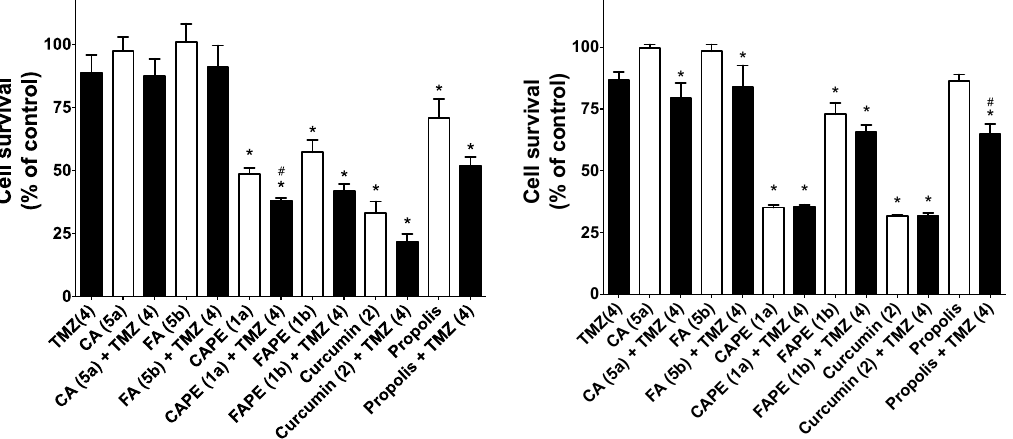
Figure 6. Cell viability of Hs683 ( left panel ) and LN319 ( right panel ) cells following treatment with compounds as described in the Methods. Values are the means ± SEM of three independent experiments, each performed in quadruplicate. * different from control (diluent) as determined by one way ANOVA with Dunnett’s multiple comparison test ( p < 0.05). # different from treatment with compound in absence of TMZ as determined by two-sided t -test ( p < 0.05).